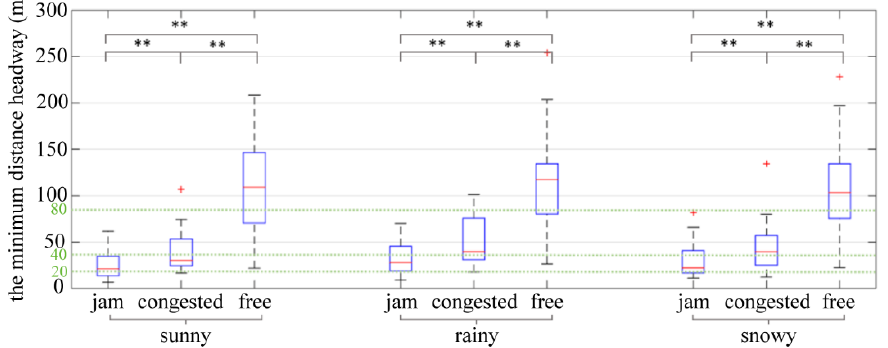
Figure 7. The minimum distance headway. ** indicates the variable was statistically significant at 0.05 level. + indicates outlier.